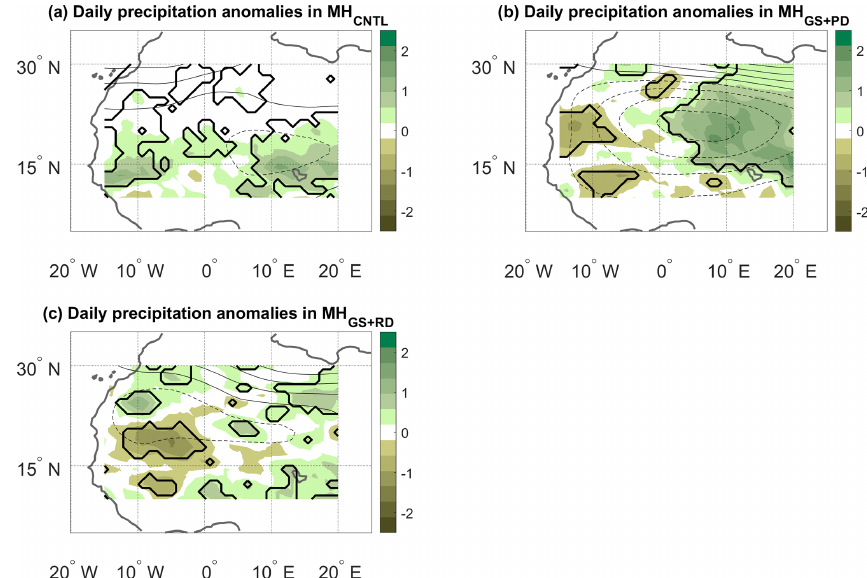
Figure A7. The same as Fig. 7 but using the domain 10–30 ◦ N, 15 ◦ W–20 ◦ E. The contour lines have an interval of 20m and span the following ranges: (a) + 40 to − 20m, (b) + 60 to − 80m, and (c) + 60 to −